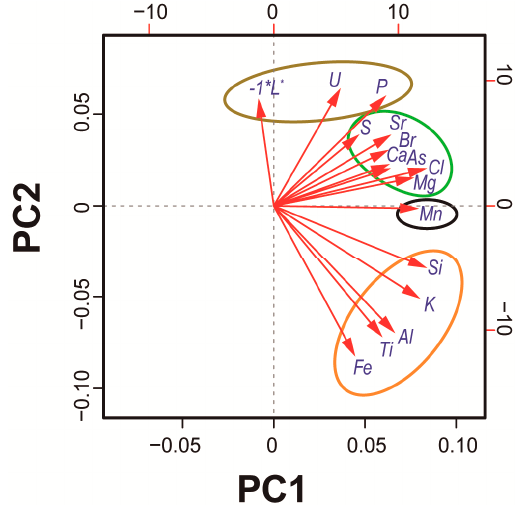
Figure 5. Biplot of the two principal components (PC) of the raw geochemical dataset. Elements with higher correlation coefficients (co-dependent) were cleaned and the lightness was expressed as − 1* L* in order to stress its relationship to the organic matter. Clusters: brown: organic matter related elements; green: groundwater affine elements; black: redox sensitive element; orange: siliciclastic fraction.